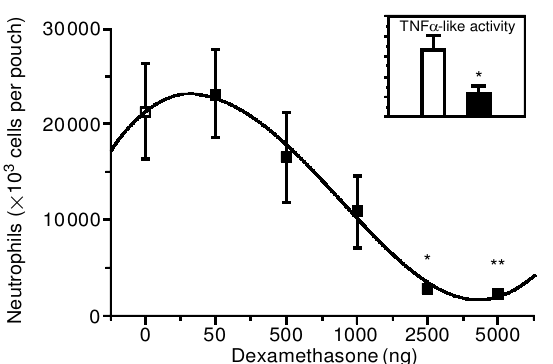
FIG. 3. Effects of dexamethasone (DEX) injected into the rat air pouches on neutrophil recruitment and TNF- a like activity induced by LPS. DEX at the doses of 50, 500, 1000, 2500 and 5000 ng ( j ) and the vehicle (0 ng) ( h ) were tested under a volume of 1 ml, 2 h before LPS (200 ng, 2 h). Neutrophil responses are expressed as mean SEM of 5 ± 7 animals per dose. TNF- a like activity (inset) was assessed for the dose of 5 m g and expressed as mean SEM of TNF- a like activity concentrations recovered in the air pouch washing supernatants for 5 animals ( P , 0.05, P , 0.01).